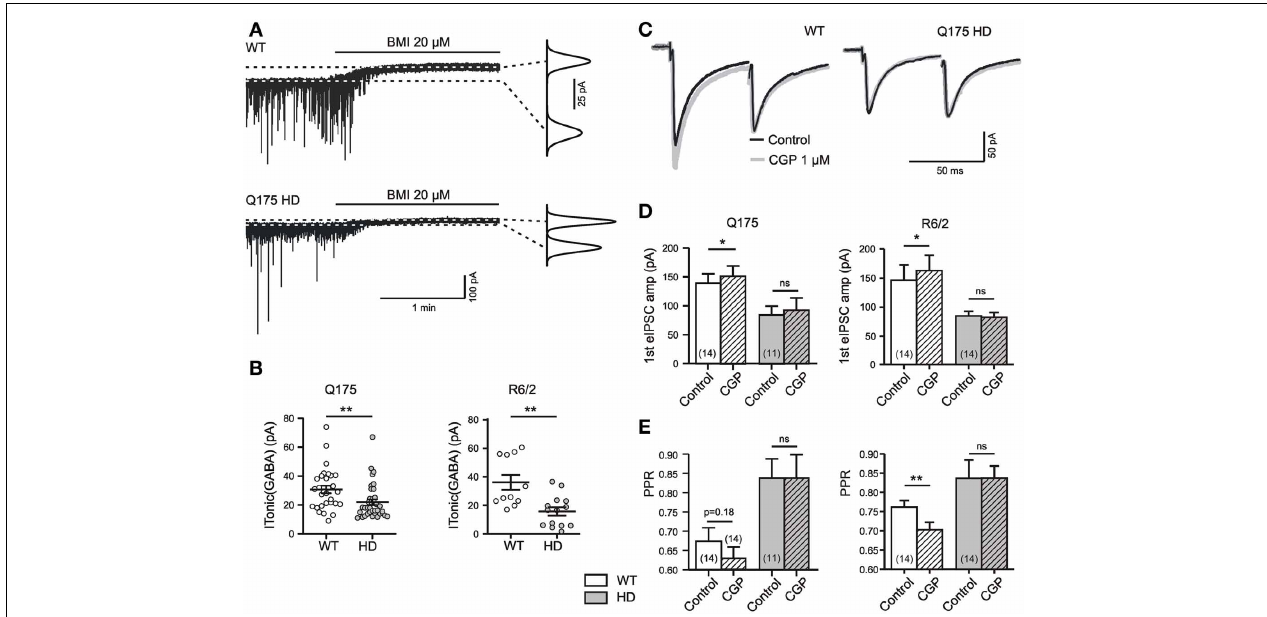
FIGURE 1 | HD-related differences in tonic GABA action in the striatum. (A) Specimen records of I Tonic ( GABA ) from SONs in slices from 1 year old WT and Q175 HD. Experiments in the presence of DNQX (10 µ M), APV (50 µ M), LY341495 (40 µ M); no K + channel block. Graphs on the right: Gaussian fits to all-points histograms derived from 30s recording periods under control conditions and in the presence of BMI. The difference between the peaks of the fitting curves represents the amplitude of I Tonic ( GABA ) as plotted in (B) . (B) I Tonic ( GABA ) obtained from WT (empty symbols) and HD mice (filled